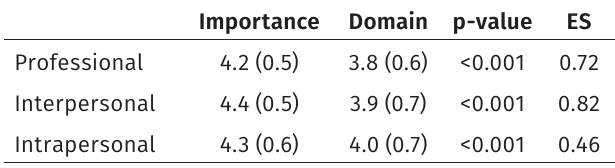
Table 3. Mean (and standard deviation) attributed importance and perceived domain about the dimensions of knowledge of racket sports coaches.